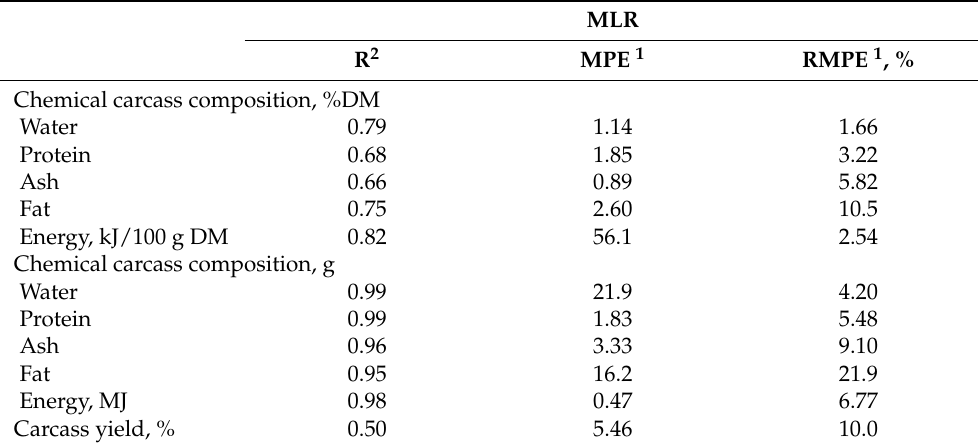
Table 5. Comparison of the prediction equations’ accuracy assessed using an independent dataset ( n = 25) via multiple linear regression (MLR). MLR R 2 MPE 1 RMPE 1 ,